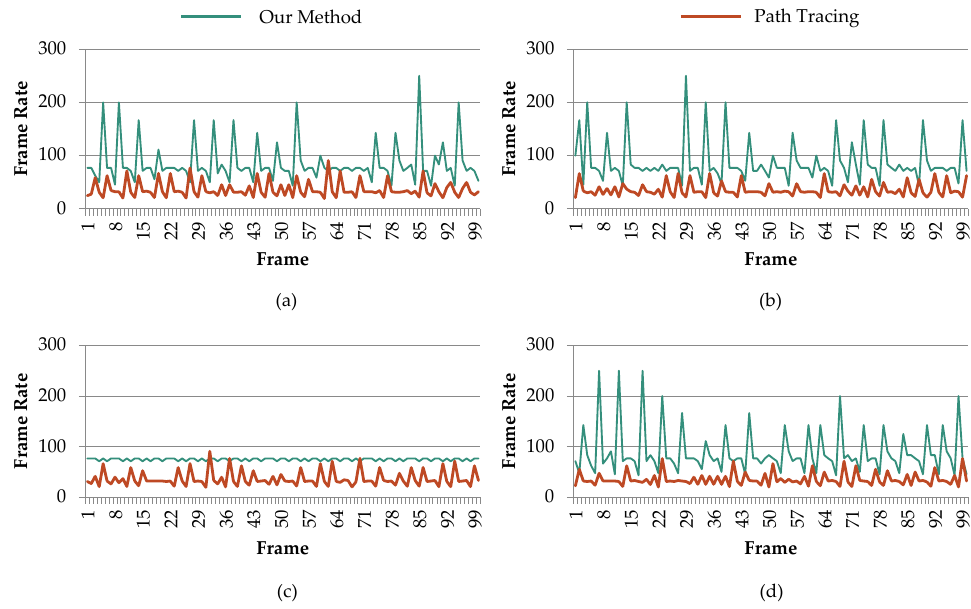
Figure 7. The time performance of rendering the cube surface light field with various image reso- lutions. ( a ) rendering resolution is 512 × 512, ( b ) rendering resolution is 1024 × 1024, ( c ) rendering resolution is 2048 × 2048, ( d ) rendering resolution is 4096 ×